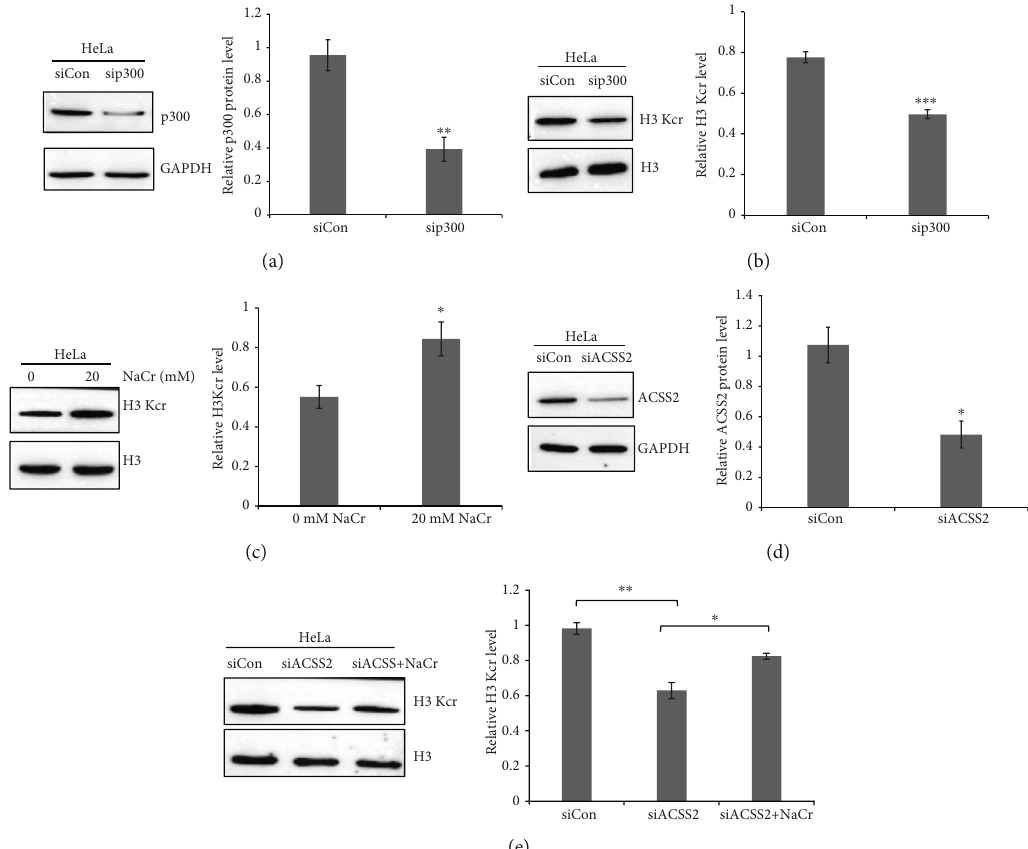
Figure 2: p300-mediated lysine crotonylation in HeLa cells. (a) p300 expression was measured by western blot in HeLa cells stably expressing nontargeting control (siCon) and sip300. The relative intensities of p300/GAPDH were quanti fi ed using ImageJ. ∗∗ P < 0 : 01 . (b) H3 Kcr expression was measured by western blot in HeLa cells stably expressing nontargeting control (siCon) and sip300. The relative intensities of H3 Kcr/H3 were quanti fi ed using ImageJ. ∗∗∗ P < 0 : 001 . (c) E ff ect of NaCr on H3 Kcr expression was determined by western blot. The relative intensities of H3 Kcr/H3 were quanti fi ed using ImageJ. ∗ P < 0 : 05 . (d) ACSS2 expression was measured by western blot in HeLa cells stably expressing nontargeting control (siCon) and siACSS2. The relative intensities of ACSS2/GAPDH were quanti fi ed using ImageJ. ∗∗ P < 0 : 01 . (e) H3 Kcr expression was determined by western blot in HeLa cell-treated siACSS2 or/and NaCr. The relative intensities of H3 Kcr/H3 were quanti fi ed using ImageJ. ∗ P < 0 : 05 ; ∗∗ P < 0 : 01